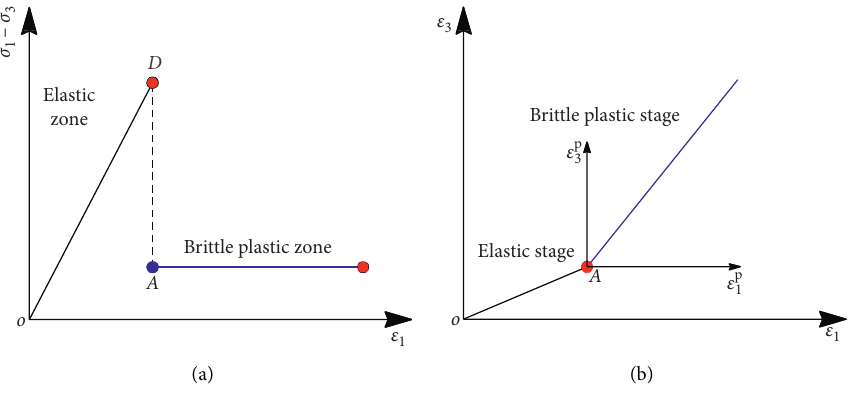
Figure 6: Postpeak failure behavior of brittle plastic rock mass.